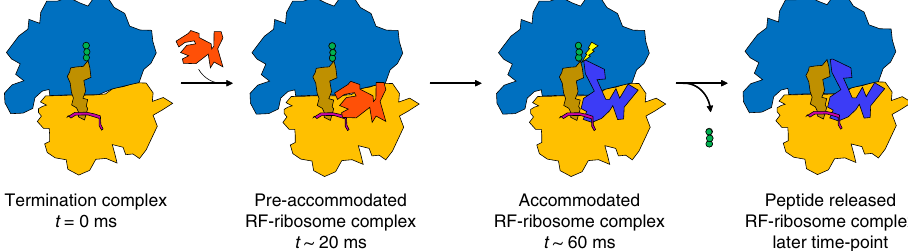
Fig. 4 Structure-based model. The sequence of states is (1) the termination complex with the stop codon at the A site, (2) the initial binding state (RF compact; “ pre-accommodated RF-ribosome complex ” ), (3) the open catalytic state (RF open/extended; “ accommodated RF-ribosome complex ” ) and (4) the state after peptide release. (The later time point is not known from our experiment, and we only know from another experiment that the fi nal state was seen after 45 s.) Blue: 50S large subunit; orange: 30S small subunit; green: tripeptide; brown: P-tRNA; pink: mRNA; red: compact RF; and